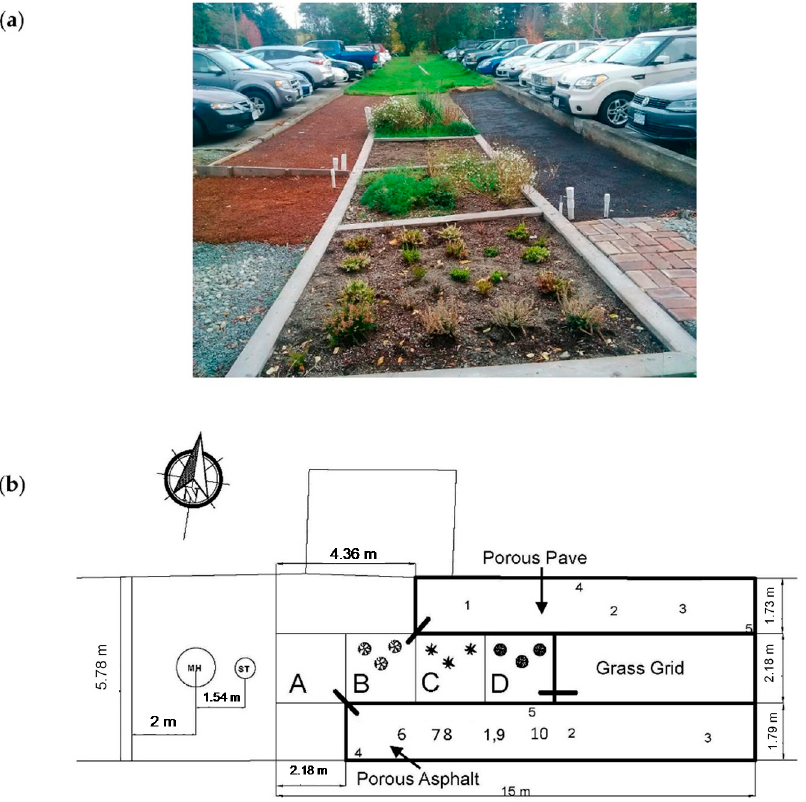
Figure 1. ( a ) The HAL field site for testing permeable surfaces in treatment trains with bioretention cells. The Porous Pave ® surface is red in color and shown in the left. The porous asphalt is the black surface shown on the right; ( b ) Plan view of the site with test locations shown numerated at the indicated locations of the test. The comma at 1,9 indicates the location of both 1 and 9.